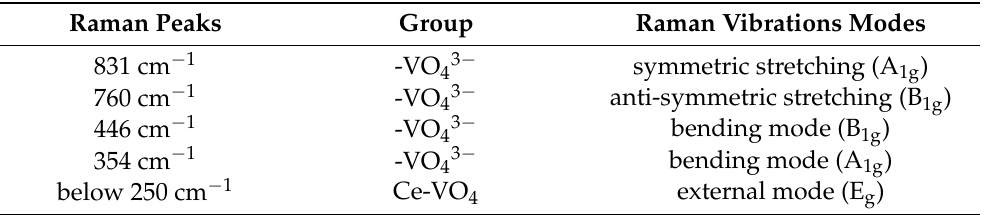
Table 2. Raman peaks and various